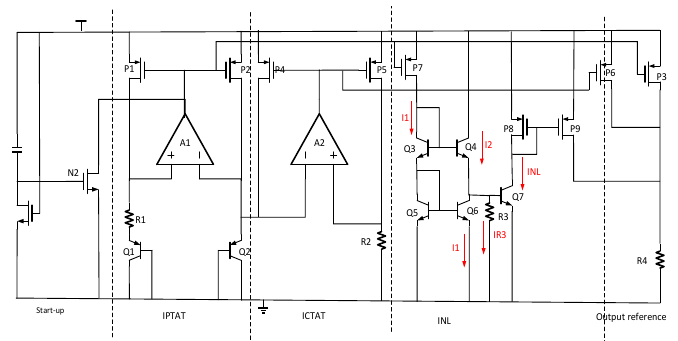
Figure 3. Proposed the first bandgap reference.